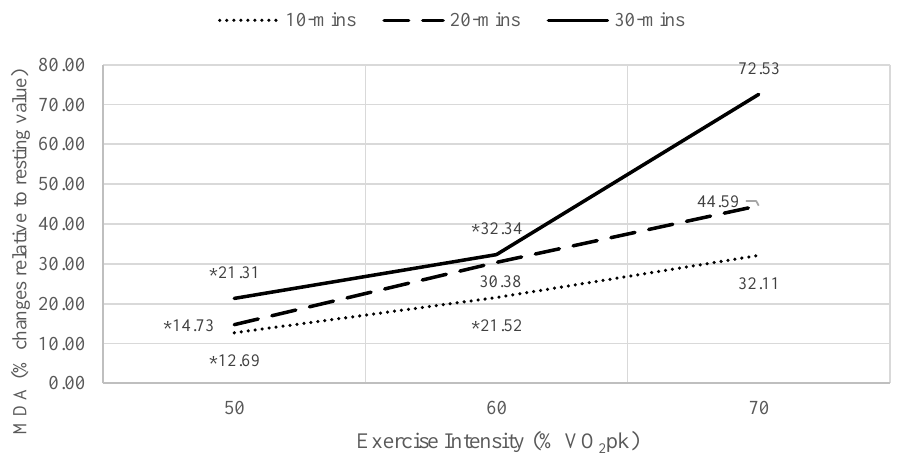
. VO 2 pk during exercise. * significantly